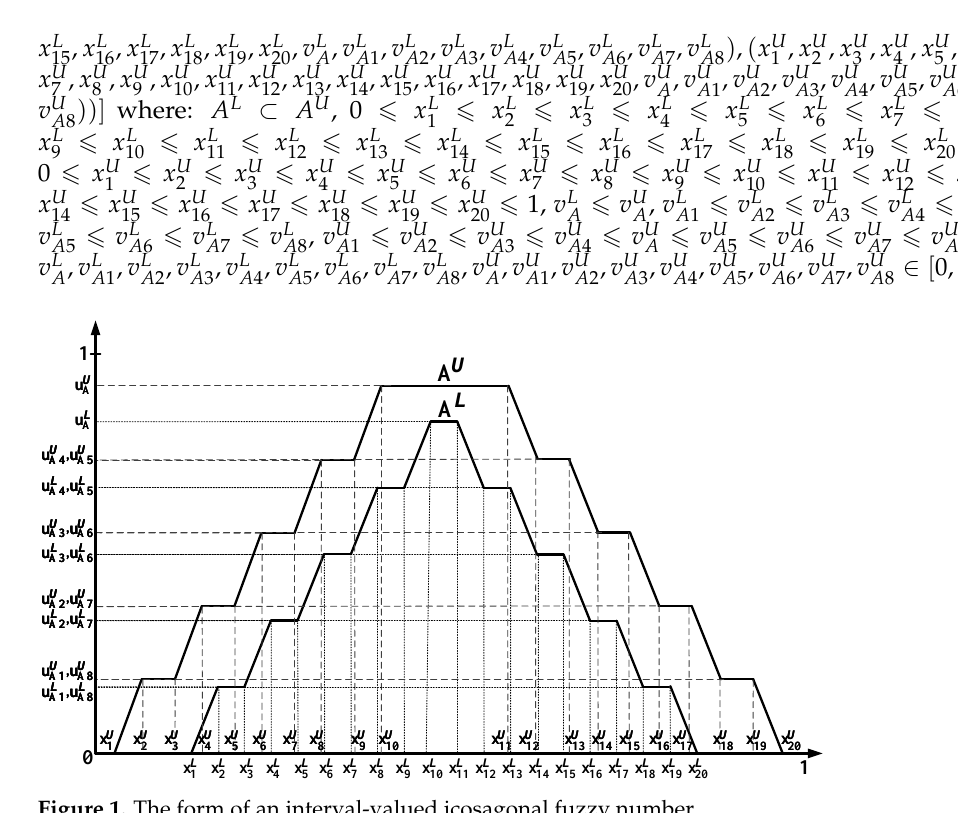
Figure 1. The form of an interval-valued icosagonal fuzzy